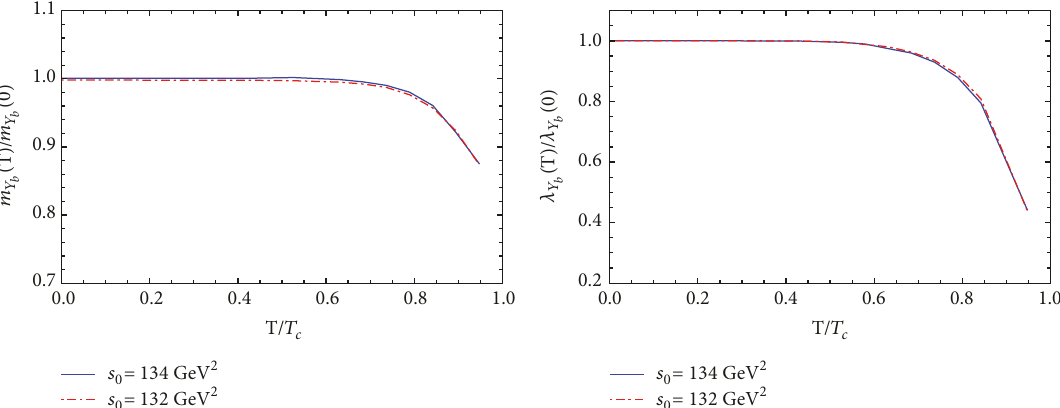
Figure 3: The mass (left) and pole residue (right) of 𝑌 푏 as a function of